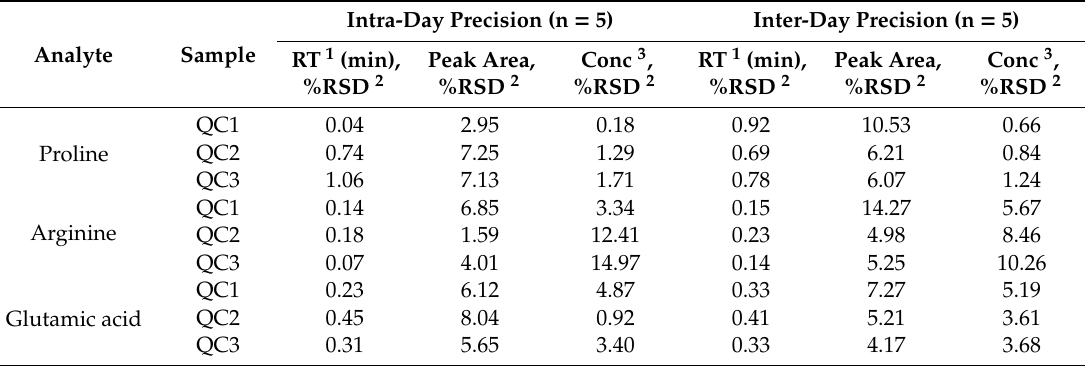
Table 1. Relative standard deviation (RSD) values in intra-day and inter-day precision tests of the developed method.